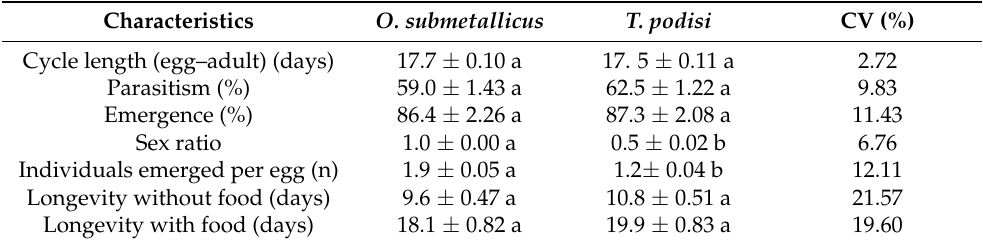
Table 1. Biological characteristics (mean ± SE) of Ooencyrtus submetallicus and Telenomus podisi reared on eggs of Euschistus heros.